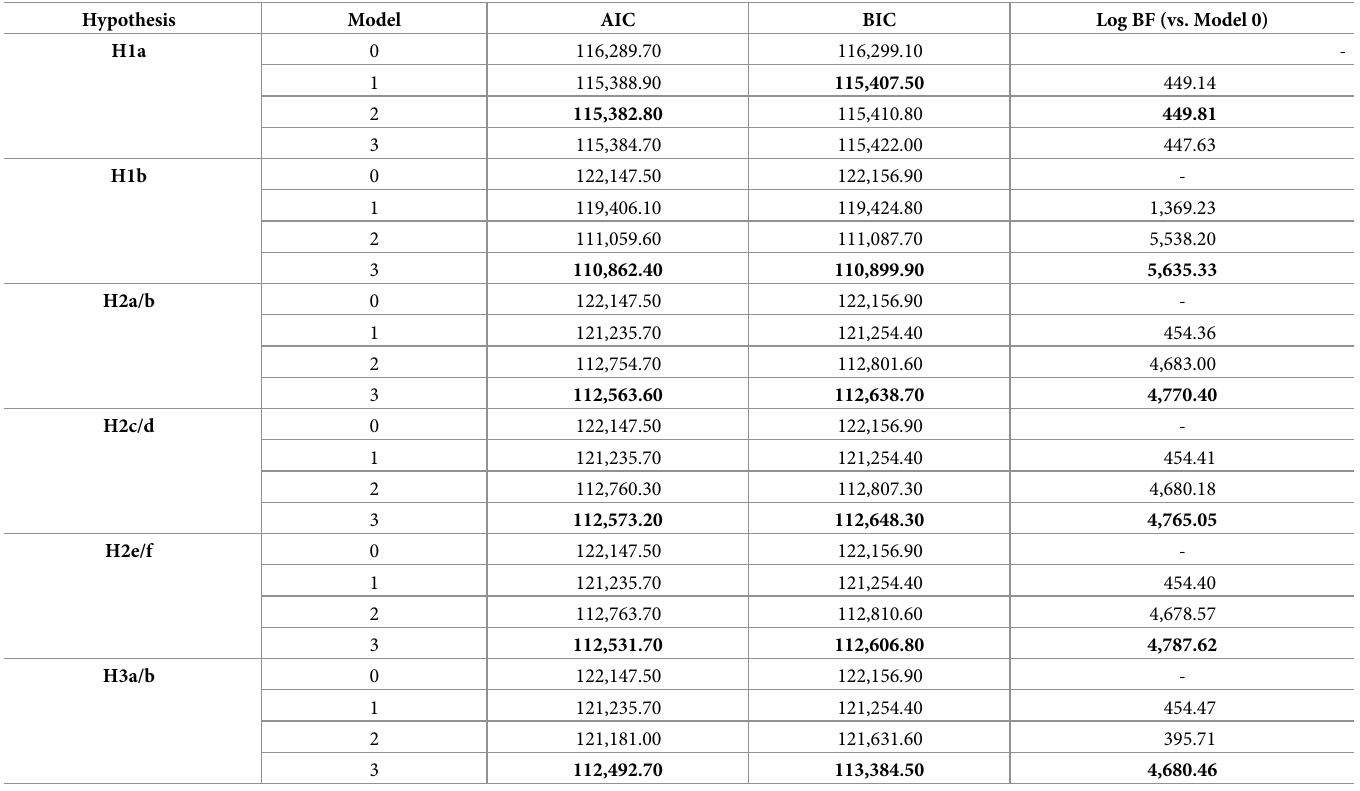
Table 3. Hypothesis testing: Model comparison.